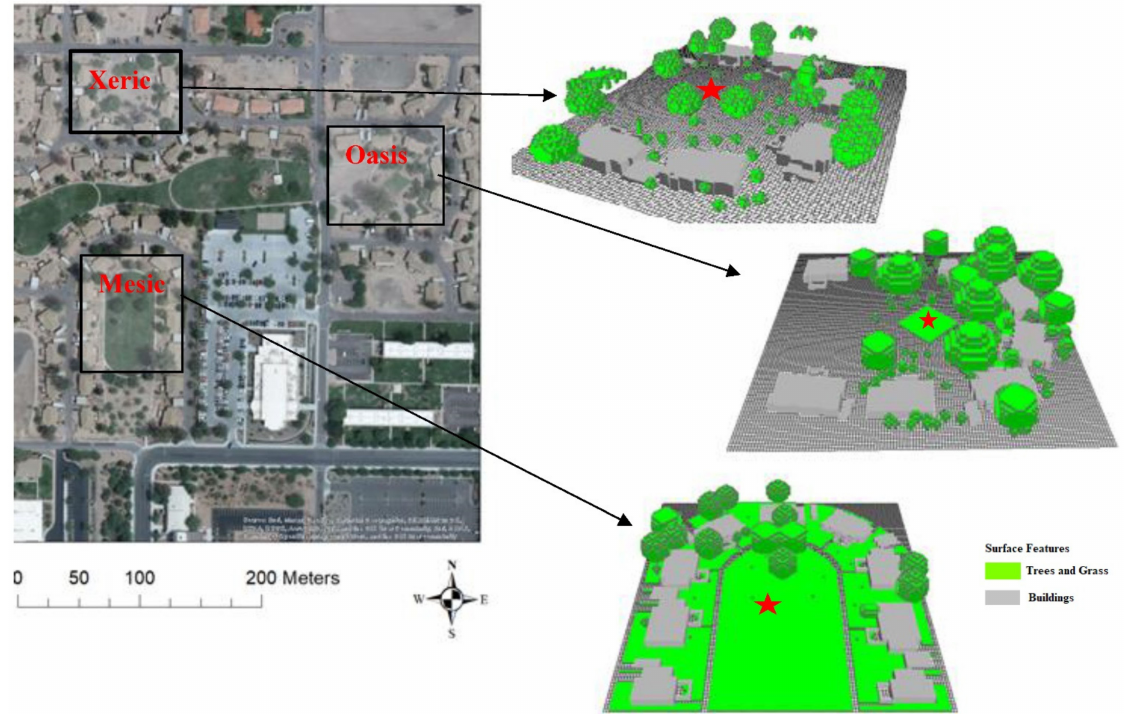
Figure 1. Study area showing the mesic, oasis, and xeric landscape with their surface features; red stars in each landscape indicate the weather station used for the model